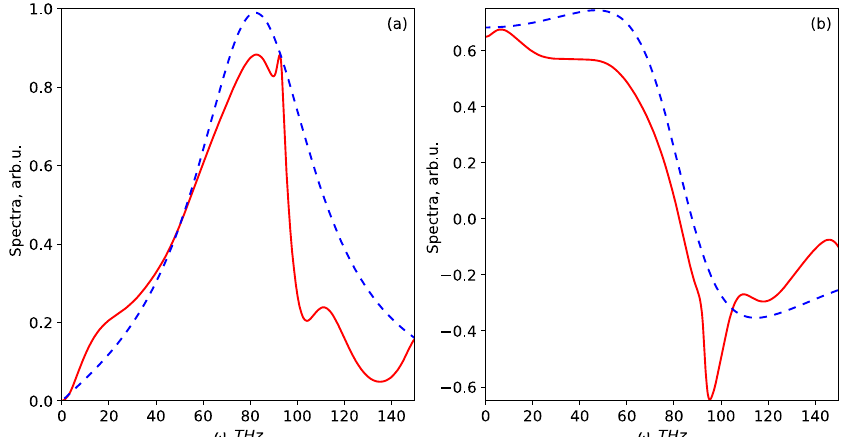
Figure 1. The comparison between the imaginary ( a ) and real ( b ) parts of spectra of Raman function R 0 ( t ) given by expression (12) (dashed blue lines) and the Raman function R ( t ) used in the modeling given by expression (11) (solid red lines).